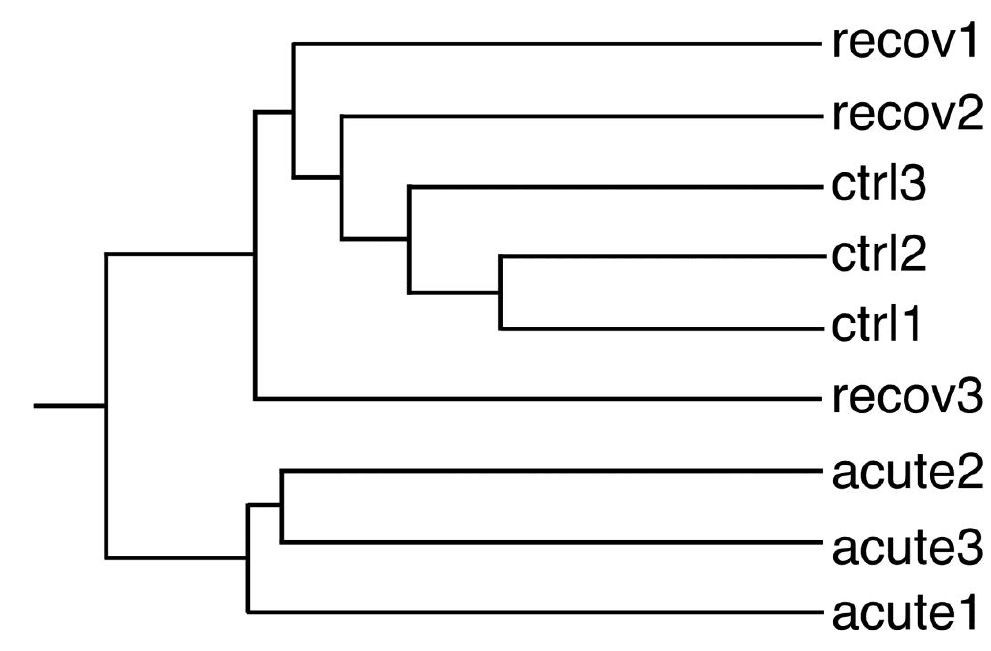
Figure 3. Global analysis of the proteomic experiment by hierarchical clustering. Quantitative proteomic data (i.e., spot intensities in 2D gel-based proteomics) were used to determine the similarities between biological samples. The PAST software package was used for calculations using the Gower similarity index and a paired group algorithm. This classification tree should be read from left to right. The earlier the bifurcation point, the more dissimilar the groups are. ctrl (1–3): unexposed cells; acute (1–3): cells exposed to pyrolytic silica for 24 h and collected just after exposure; recov (1–3): cells exposed to pyrolytic silica for 24 h and left to recover without silica for 72 h. Thus, this tree shows that proteome-wise, the cells just at the end of the exposure time were the most different from the other two conditions, while the three replicates for the acute condition were quite consistent among themselves. The three replicates for control cells were also consistent, while the replicates for the recovery condition were less consistent, indicating variability detected at the proteome scale.